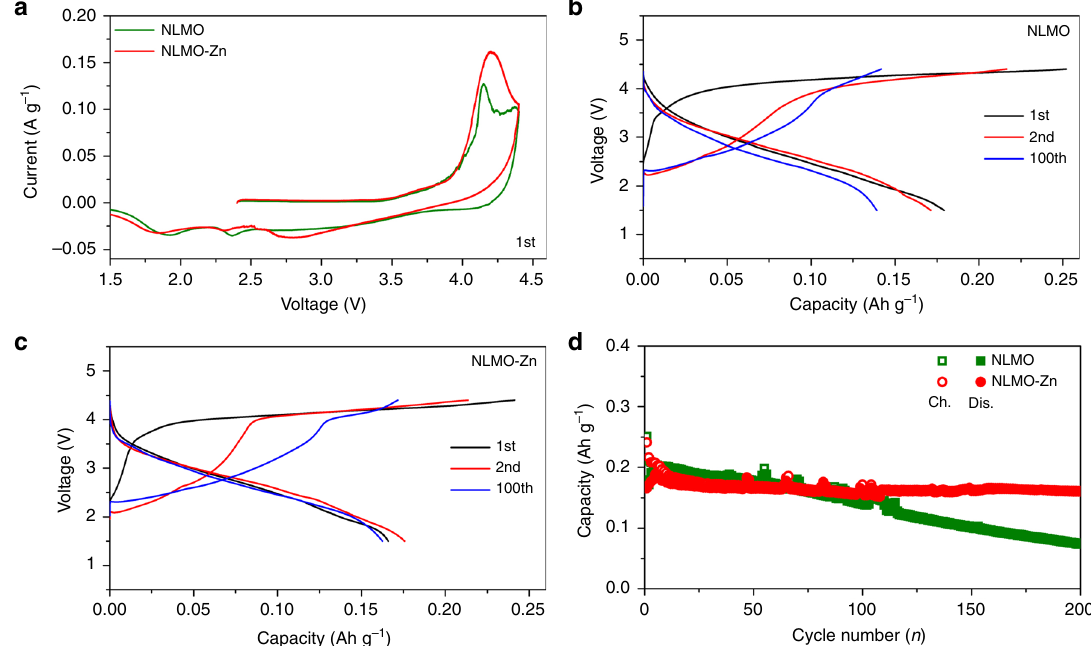
Fig. 7 Cycling performance and electrochemical behaviours of NLMO and NLMO-Zn. CVs of NLMO and NLMO-Zn in the 1st cycle ( a ). Charge-discharge curves of NLMO ( b ) and NLMO-Zn ( c ) in the 1st, 2nd, and 100th cycle. Comparison of the cycling performance between NLMO and NLMO-Zn at 0.2 C ( d